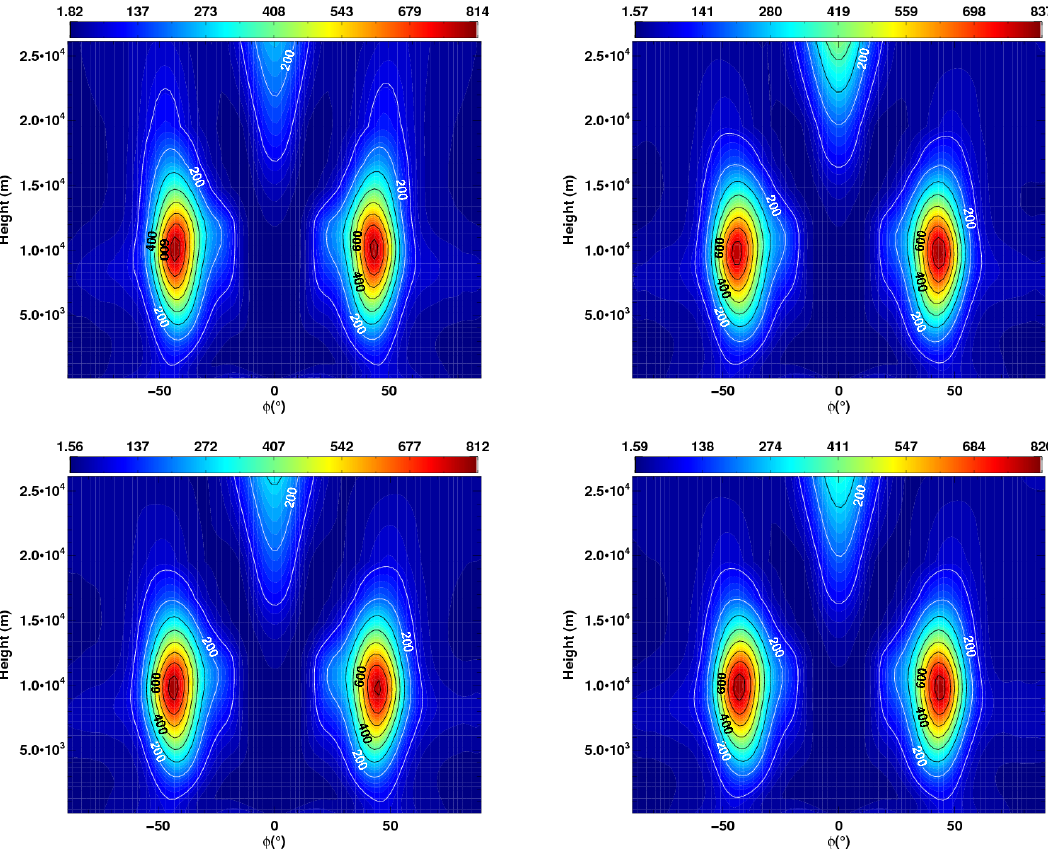
Figure 6. Figure, for the Held–Suarez test (Held and Suarez, 1994), showing the zonally (in geometric height) and temporally averaged EKE (see Sect. 3.1) as a function of latitude and height. Top left panel: ND, top right panel: EG sh , bottom left panel: EG gc and bottom right panel: EG models (see Table 2 for explanation of model types). Note the contours (solid lines) are the same in all plots.